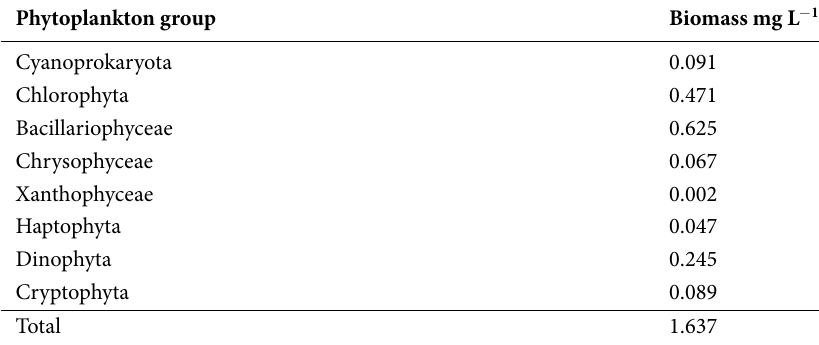
Table 3 e biomass of particular taxonomic groups of the phytoplankton assemblage in the summer of